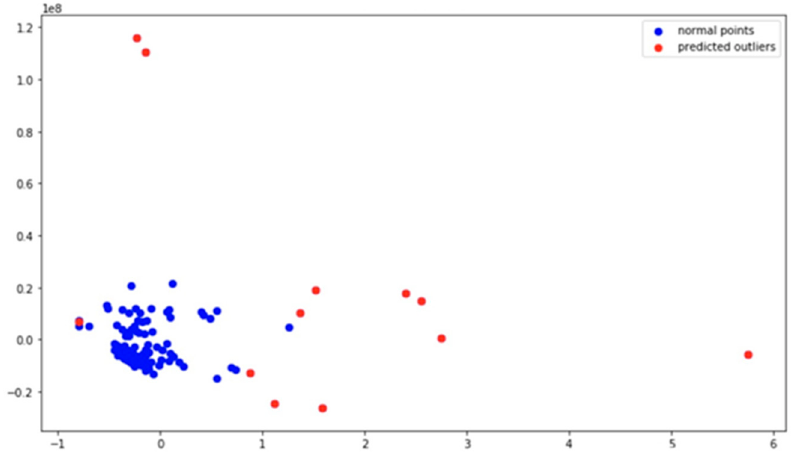
Figure 9. Outlier detection suitable for clustering method.